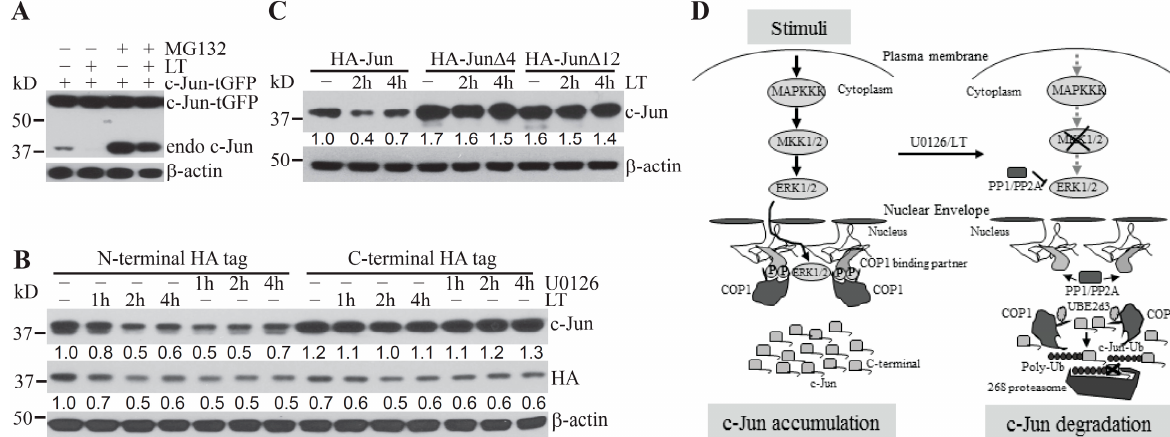
Figure 4. Regulation of c-Jun degradation by its distal C-terminus and a schematic model for the regulation of COP1- mediated c-Jun degradation. ( A ) Hepa1c1c7 cells transiently expressing c-Jun-tGFP were pretreated with 10 µM MG132 for 30 min and then cultured with or without LT for 2 h. ( B , C ) Hepa1c1c7 cells were transduced with pseudo retroviruses expressing c-Jun with either an HA-tag at its N-terminus or at its C-terminus ( B ), N-terminal HA-tagged full-length c-Jun, or c-Jun with a deletion of its C-terminal 4 (HA–Jun Δ 4) or 12 (HA–Jun Δ 12) amino acids ( C ). Hepa1c1c7 cells transduced with the indicated c-Jun constructs were treated with U0126 or LT as indicated. Cells ( A – C ) were extracted with NuPAGE LDS sample buffer following the treatment. Levels of the indicated proteins in the cell lysates were assessed by Western blotting. Band intensities of c-Jun were quantified and normalized using β -actin levels ( B , C ). The normalized protein levels are shown under each band. Data shown are representative of at least two independent experiments. ( D ) Extracellular stimuli activate the MAPKKK–MKK1/2–Erk1/2 signaling cascade. Activated Erk1/2 then induces the phosphorylation of COP1-binding partners, promoting sequestration of COP1 and accumulation of c-Jun protein (left panel). Deprivation of extracellular stimuli or inhibition of MKK1/2 by U0126/LT causes deactivation of Erk1/2 and dephosphorylation of COP1- binding partners, leading to the release of COP1. COP1, in turn, mediates c-Jun degradation by proteasome through a mechanism dependent upon UBE2d3- and the C- terminus of c-Jun (right panel).